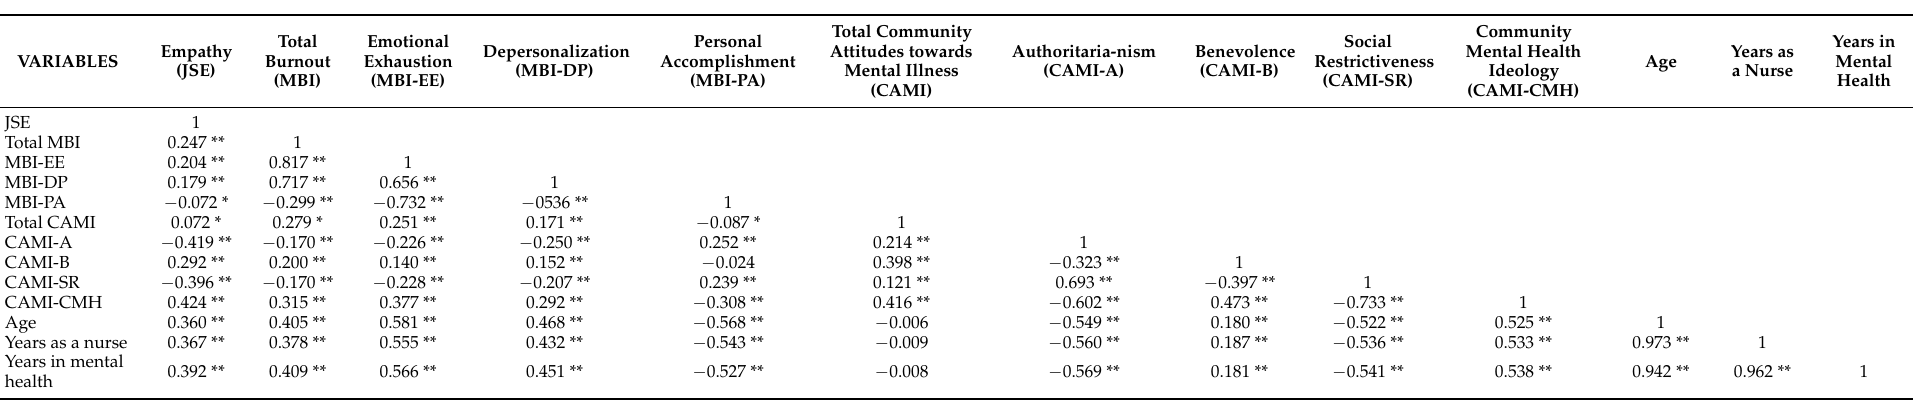
Table 3. Spearman’s rank correlation matrix between study